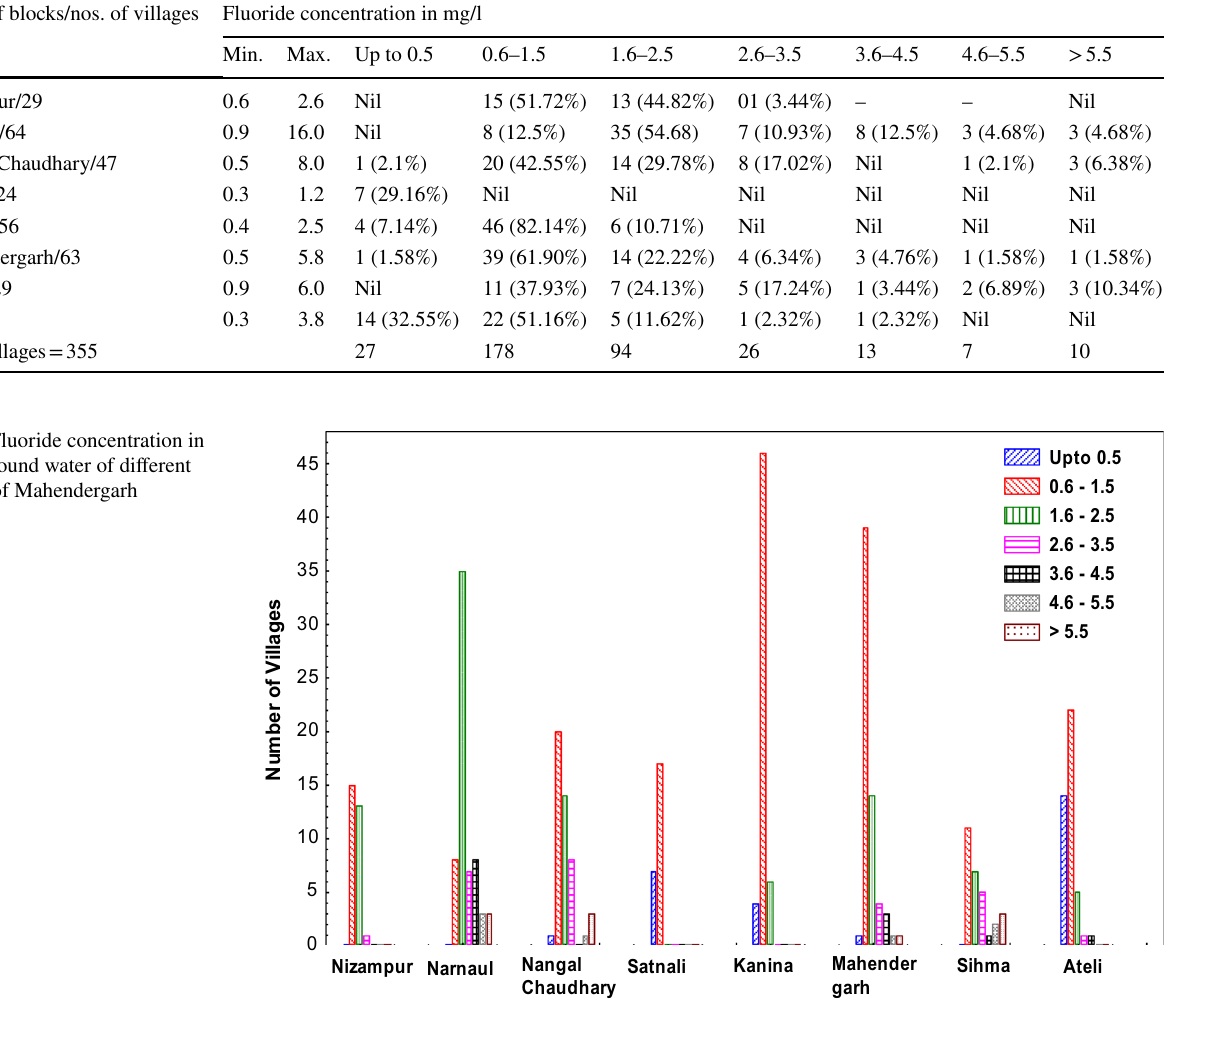
Table 9 Fluoride distribution in all the eight blocks of district Mahendergarh Name of blocks/nos. of villages Fluoride concentration in mg/l